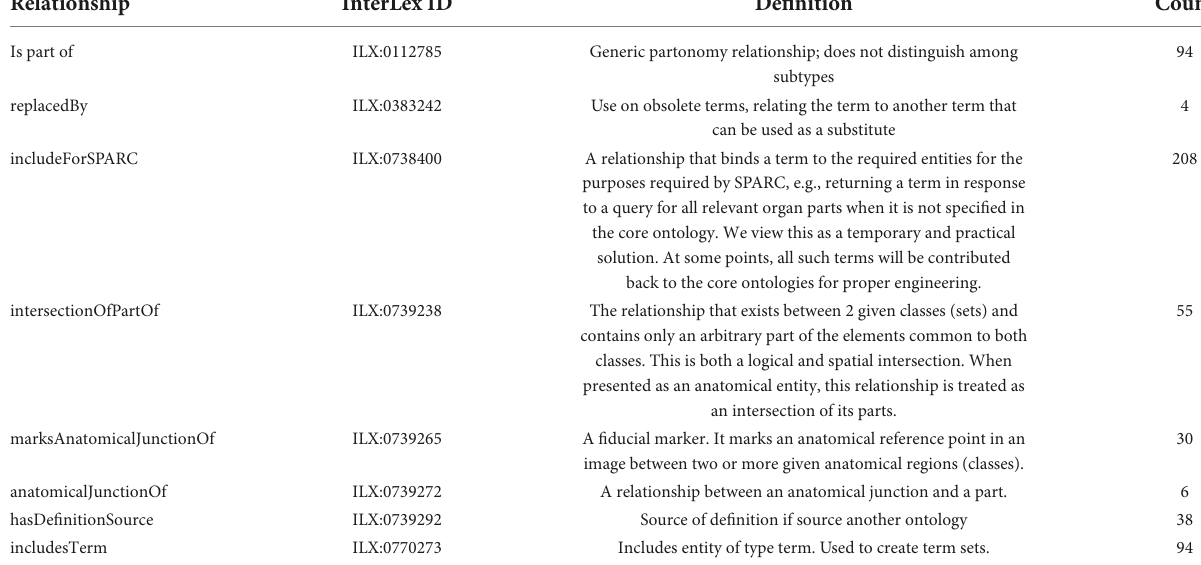
TABLE 1 Relationships entities used within the term request